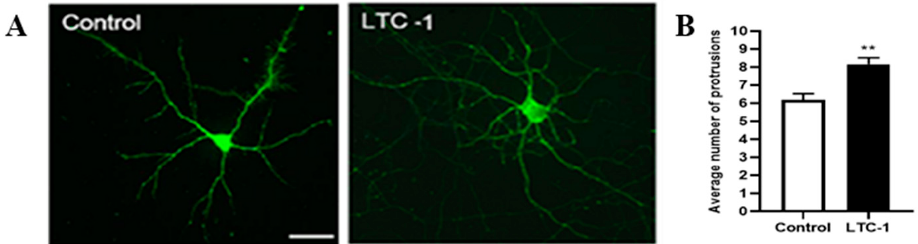
Figure 8. The number of dendrites of hippocampal neurons increased after treatment with LTC-1. ( A ) The growth status of single hippocampal neuron dendrites 24 h after drug treatment. ( B ) Statistical graph of the sum of the number of primary and secondary dendrites after administration. The mean (SD) is used to express the data. One-way ANOVA was used for statistical analysis, followed by Tukey’s multiple comparison test, ** p < 0.01 vs. the control